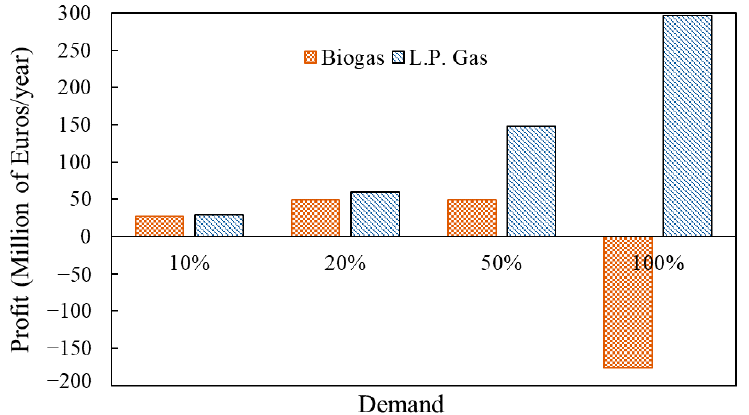
Figure 4. Profit comparison between biogas and LPG to satisfy an energy demands of the studied geographical region.